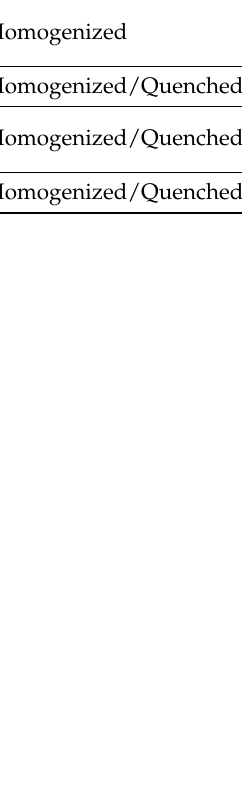
Table 3. The concentrations of the phases and lattice parameters were obtained by Rietveld